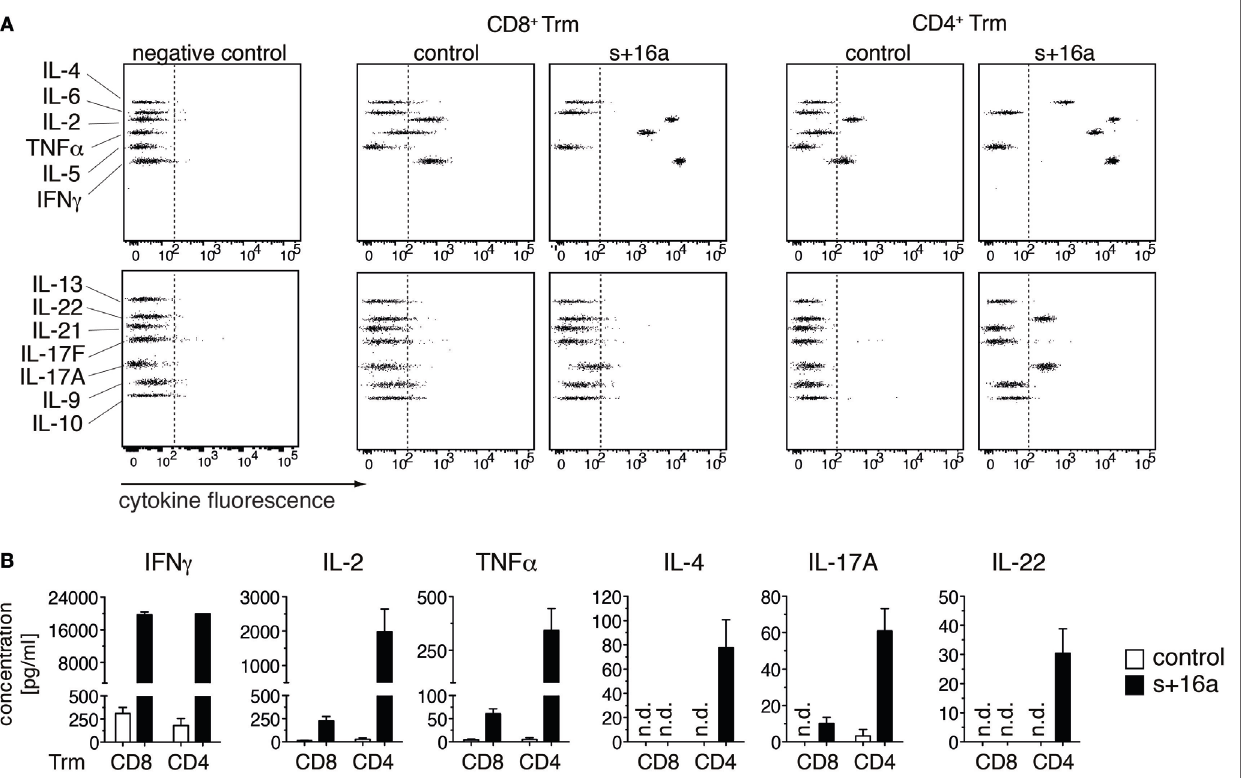
FIgURe 3 | In vitro cytokine expression profile of PMA/ionomycin stimulated liver Trm. (A) CD8 + (1 × 10 4 cells) and CD4 + (2 × 10 4 cells) Trm from the liver of Lm infected mice were FACS sorted 7 weeks after infection. One group of mice was treated with s + 16a prior to organ harvesting and the second group was left untreated as control. Cells were stimulated with PMA/ionomycin for 20 h and T cell cytokines [IFN γ , TNF α , interleukin (IL)-2, IL-4, IL-21, IL-22, IL-17A, IL-17F, IL-10, IL-9, IL-5, and IL-13] were measured in the supernatants using a bead-based 13-plex assay. (B) The concentration of cytokines in the supernatants of stimulated CD4 + and CD8 + Trm from s + 16a-treated and control mice ( n = 3) was